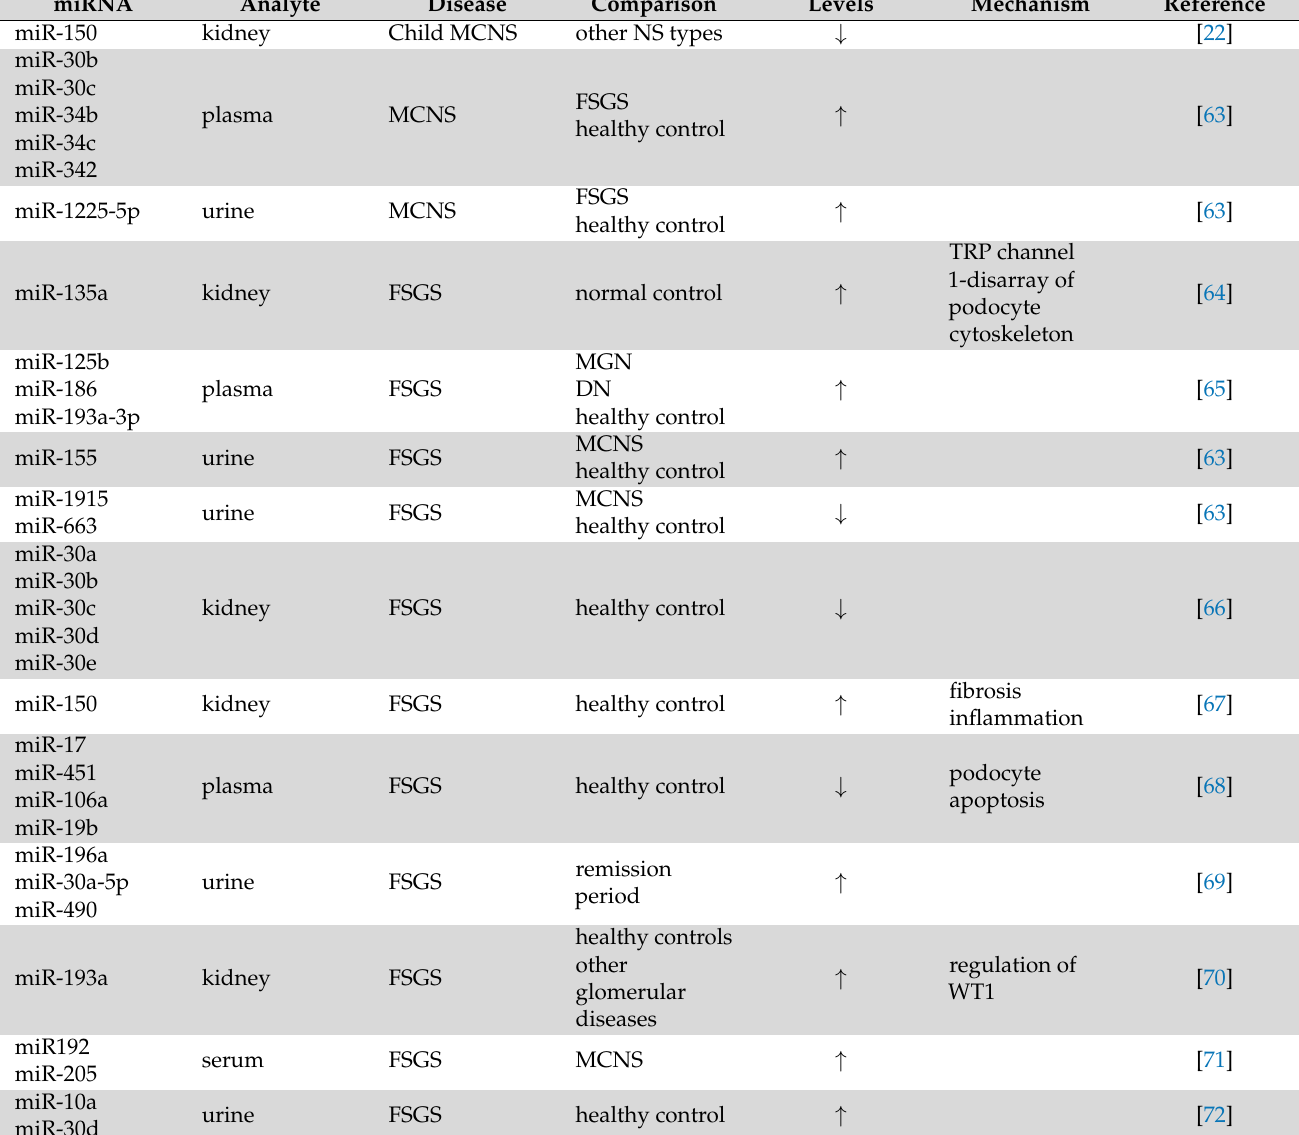
Table 3. MiRNAs in minimal change nephrotic syndrome and focal segmental glomerulosclerosis.